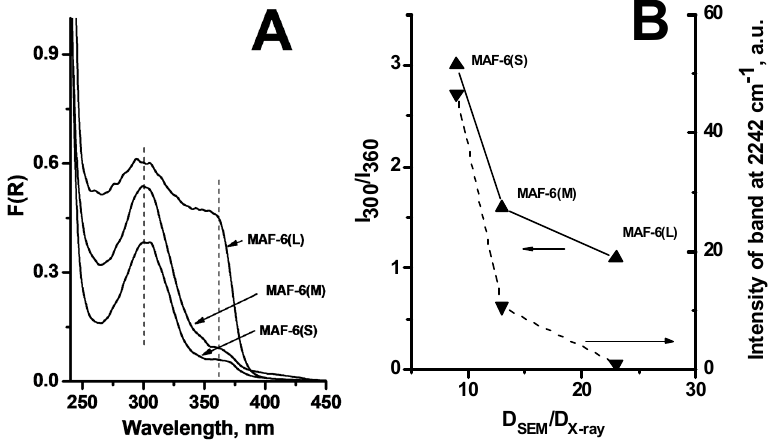
Figure 4. ( A ) DR-UV–Vis spectra of MAF-6 samples with different particle size. ( B ) Correlation be-